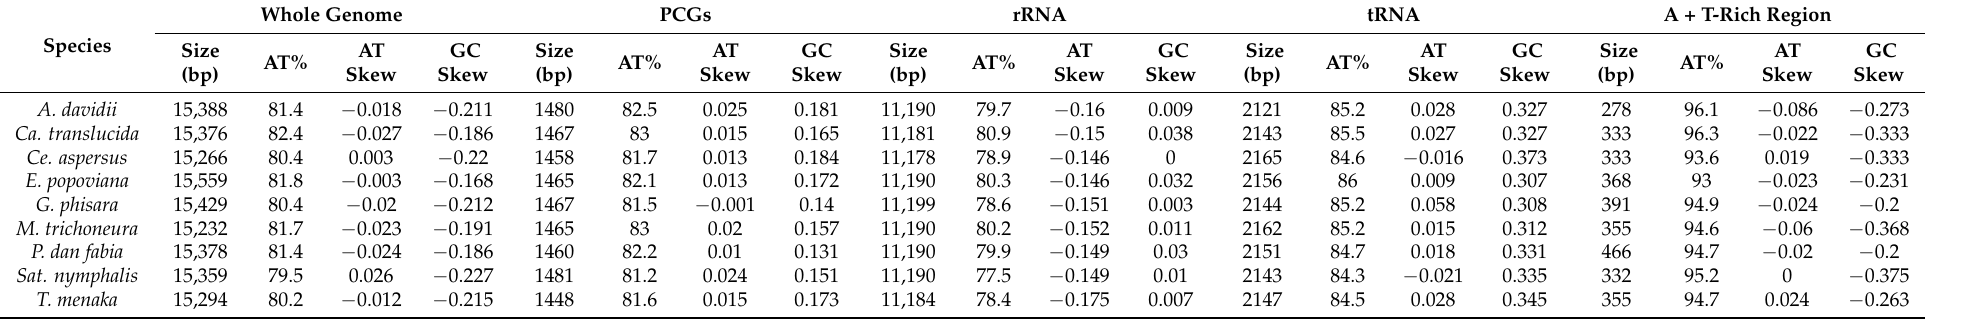
Table 3. Nucleotide composition and skewness of the nine